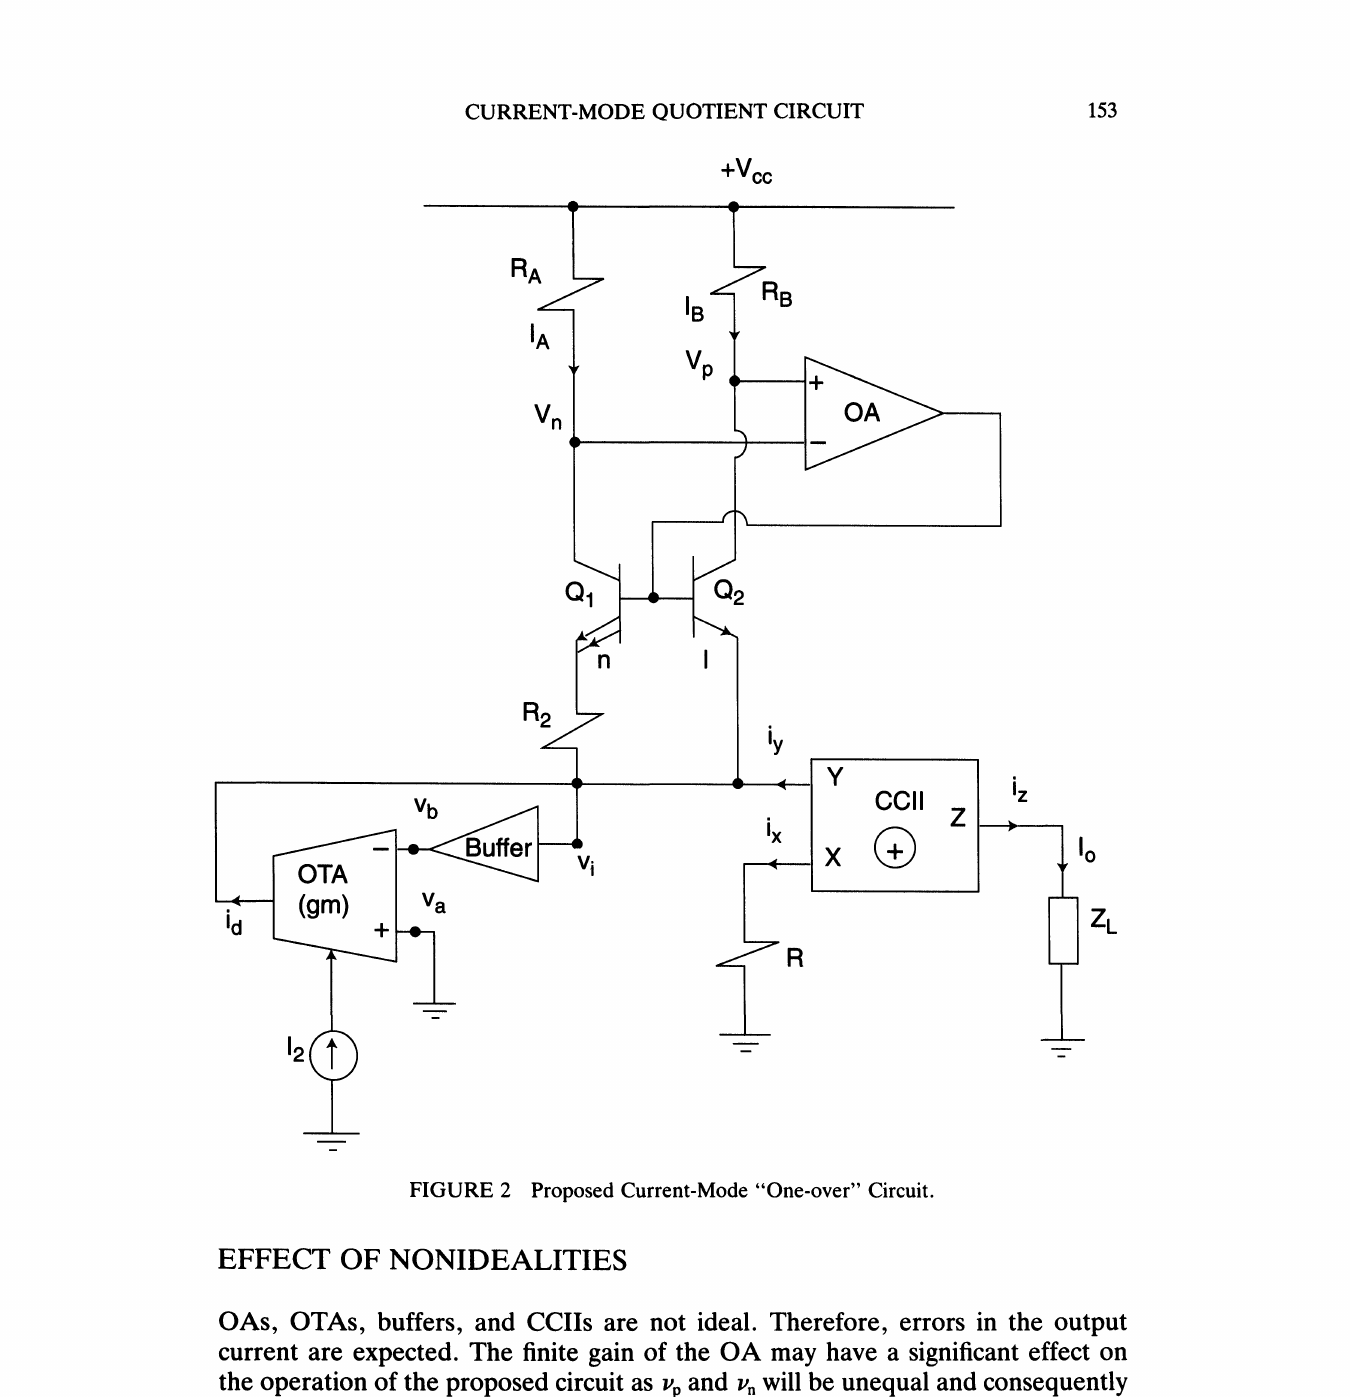
FIGURE 2 Proposed Current-Mode "One-over"